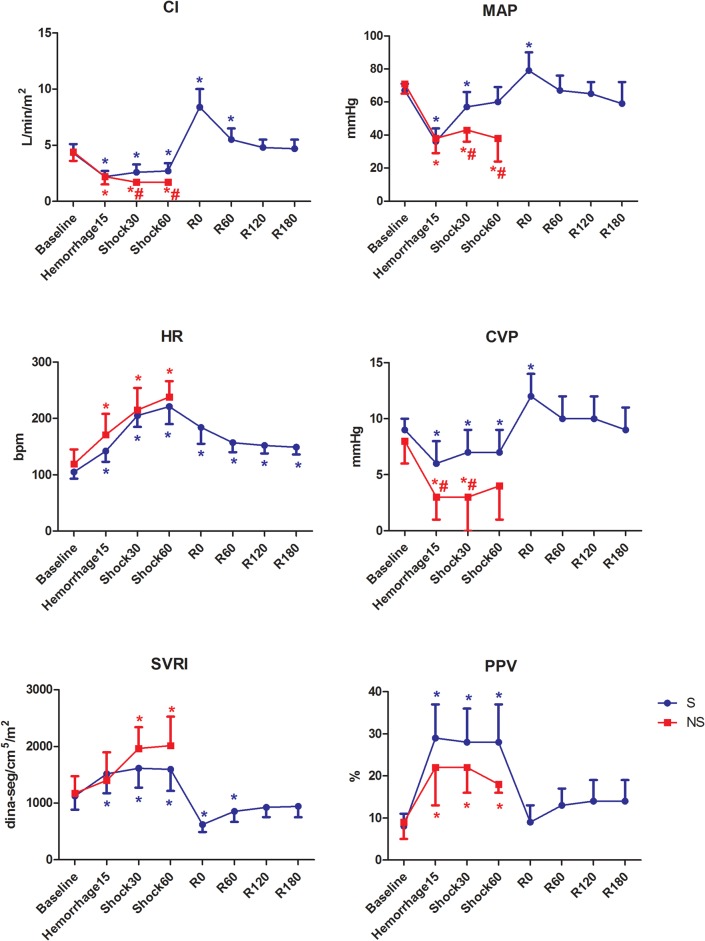
Hemodynamic variables in pigs submitted to acute hemorrhagic shock and fluid resuscitation.S = survivor group. NS = non-survivor group; * = P<0.05 different from baseline; # = p<0.05 NS group different from the S group (t test).